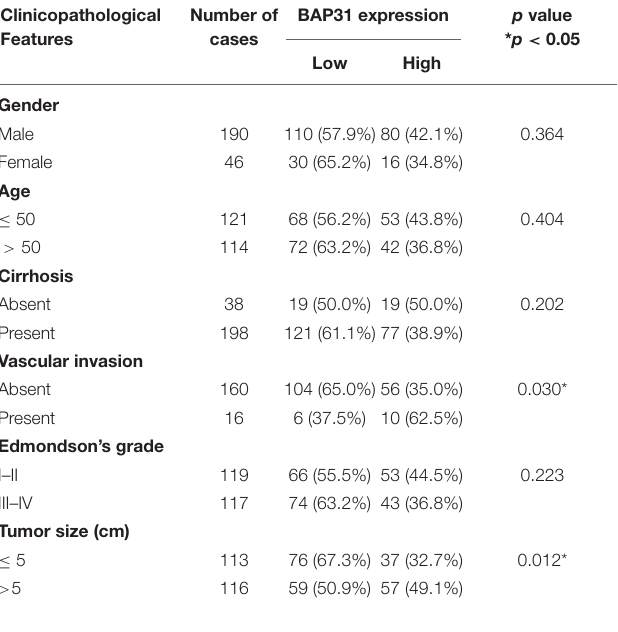
TABLE 1 | Clinicopathological analysis of BAP31 expression in HCC tissues. Clinicopathological